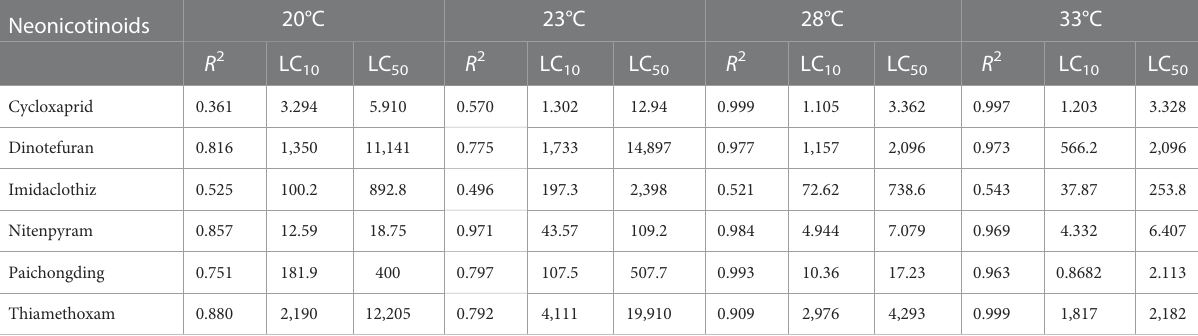
TABLE 1 The embryonic 96-h 10% and 50% lethal concentration (LC 10/50 , mg/L) of six neonicotinoids under different temperature conditions [curves were fi tted to sigmoidal (log) dose – response curve (variable slope) with a four-parameter logistic equation in GraphPad Prism (version 5.0, San Diego, CA,